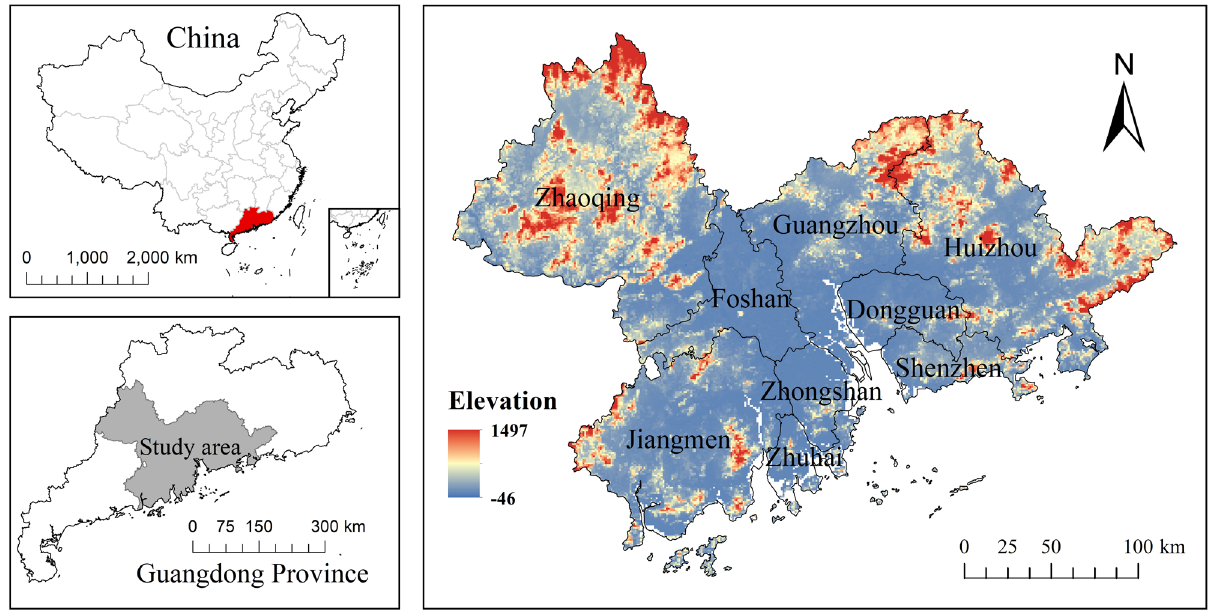
Figure 1. Geographical location of Pearl River Delta drawn in ArcGIS 10.6.